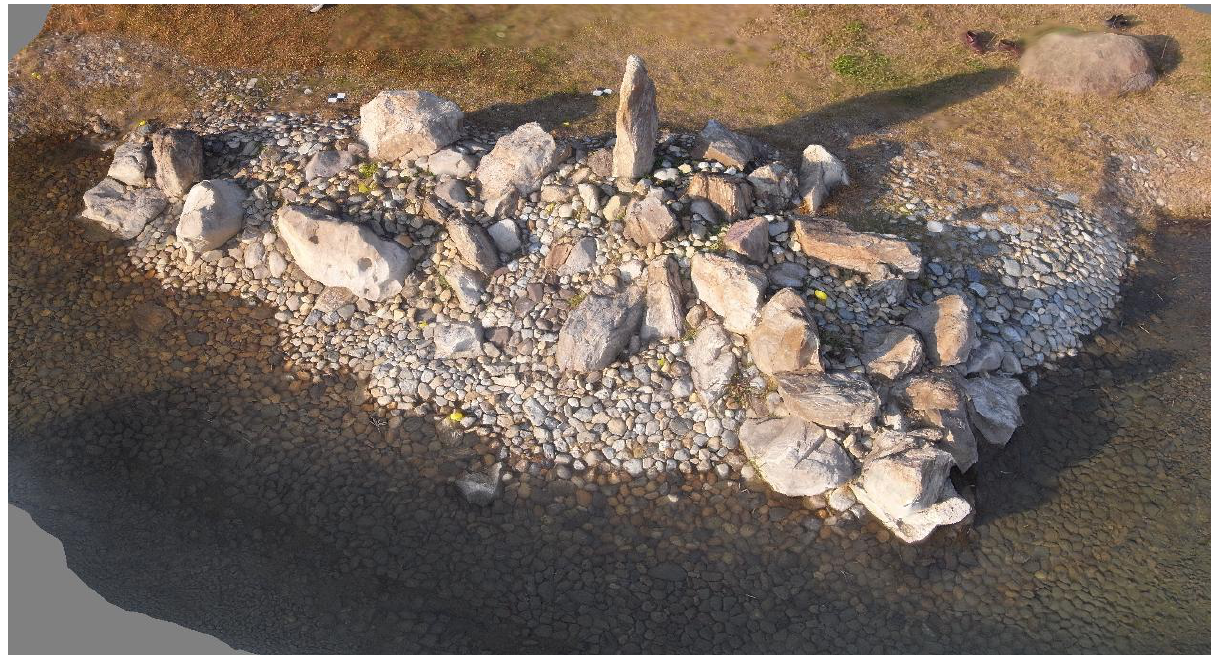
Figure 4. 3D model of the garden rocks at the Toin Garden bySfM.